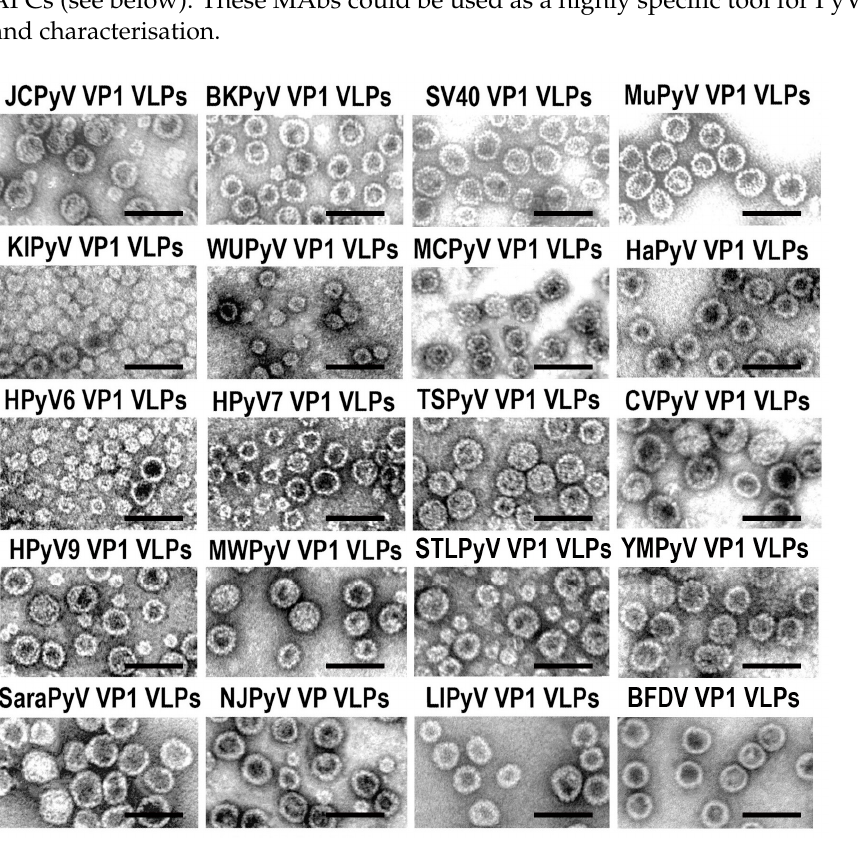
Figure 2. Electron-microscopical images of the recombinant PyV VP1-derived VLPs produced in yeast Saccharomyces cerevisiae that were used in this study. The scale bar (black line) represents 100 nm.